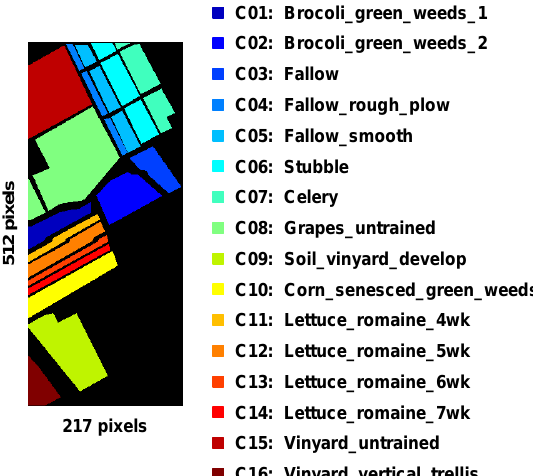
Figure 3. Reference labels for the Salinas dataset: each pixel is characterized by reflectance values on 204 spectral bands. Unla- beled pixels are indicated in black.